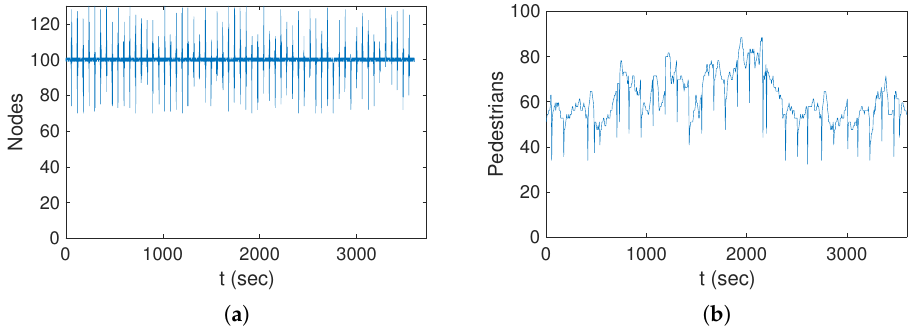
Figure 3. Number of individuals along time. ( a ) Plaza scenario; ( b ) Station